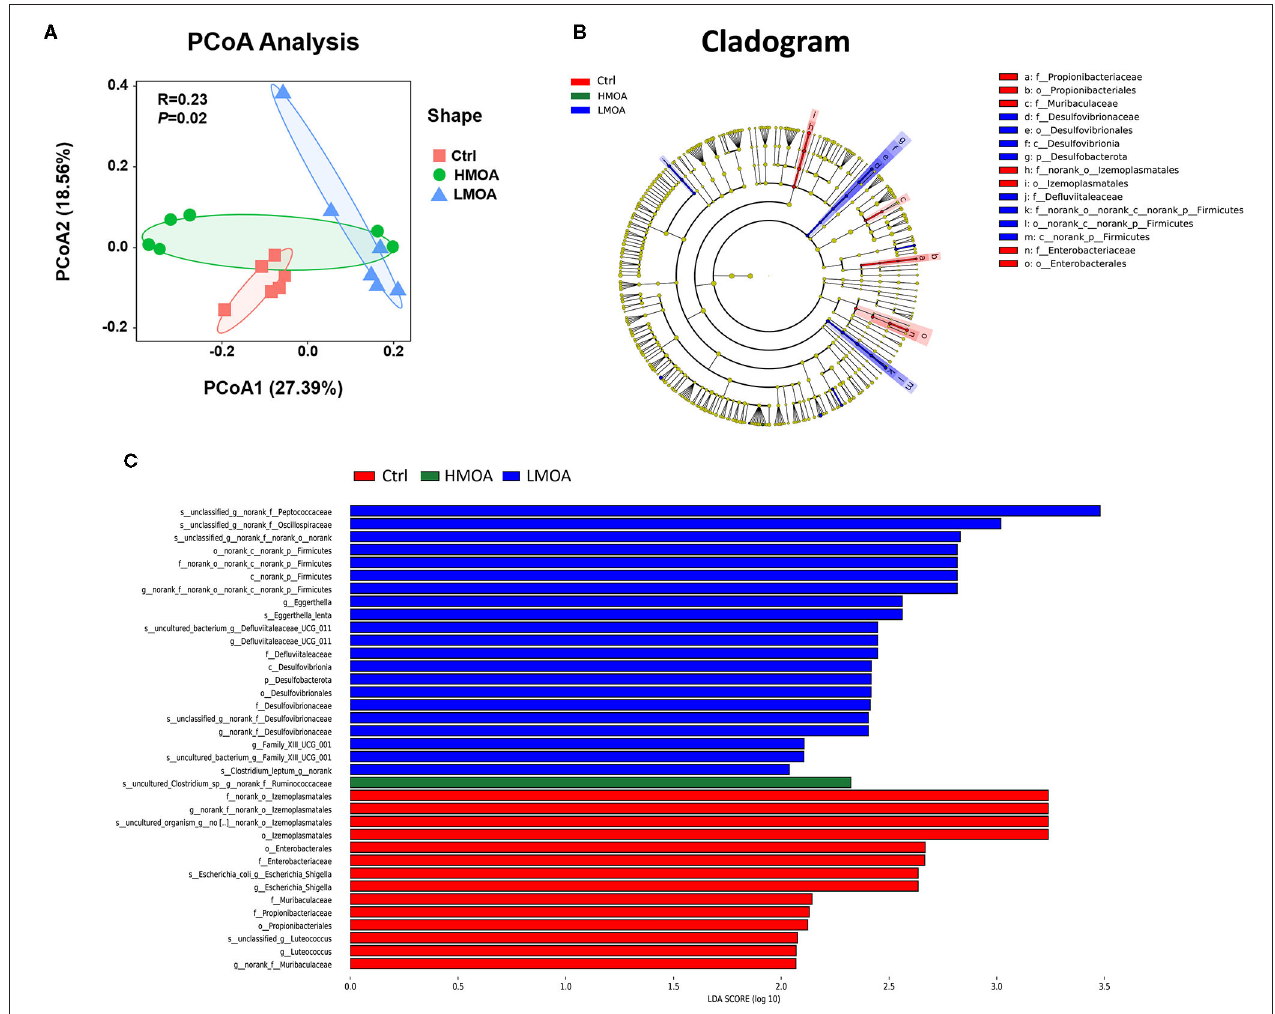
FIGURE 7 | The analysis of bacterial β -diversity and microbial structures in 42 d-broilers cecum as affected by dietary MOA supplementation. (A) Principal co-ordinates analysis (PCoA) diagram of the cecum bacterial communities based on bray-Curtis distance calculated from OTUs abundance matrix. The significant difference test between groups using Analysis of similarities (ANOSIM). (B) Discriminant analysis of LEfSe multi-level species difference from phylum to genus level. (C) Histogram of linear discriminant analysis (LDA) from phylum to genus level. The values were examined by the non-parametric factorial Kruskal-Wallis sum-rank test to identify the microorganisms with significant difference characteristics and using linear discriminant analysis to estimate the magnitude of the effect of abundance on the difference effect for each species. Ctrl: a basal diet of corn-soybean meal with 0 mg/kg of mixed organic acid; LMOA: a basal diet with 3,000 mg/kg of mixed organic acids; HMOA: a basal diet with 6,000 mg/kg of mixed organic acids. n =